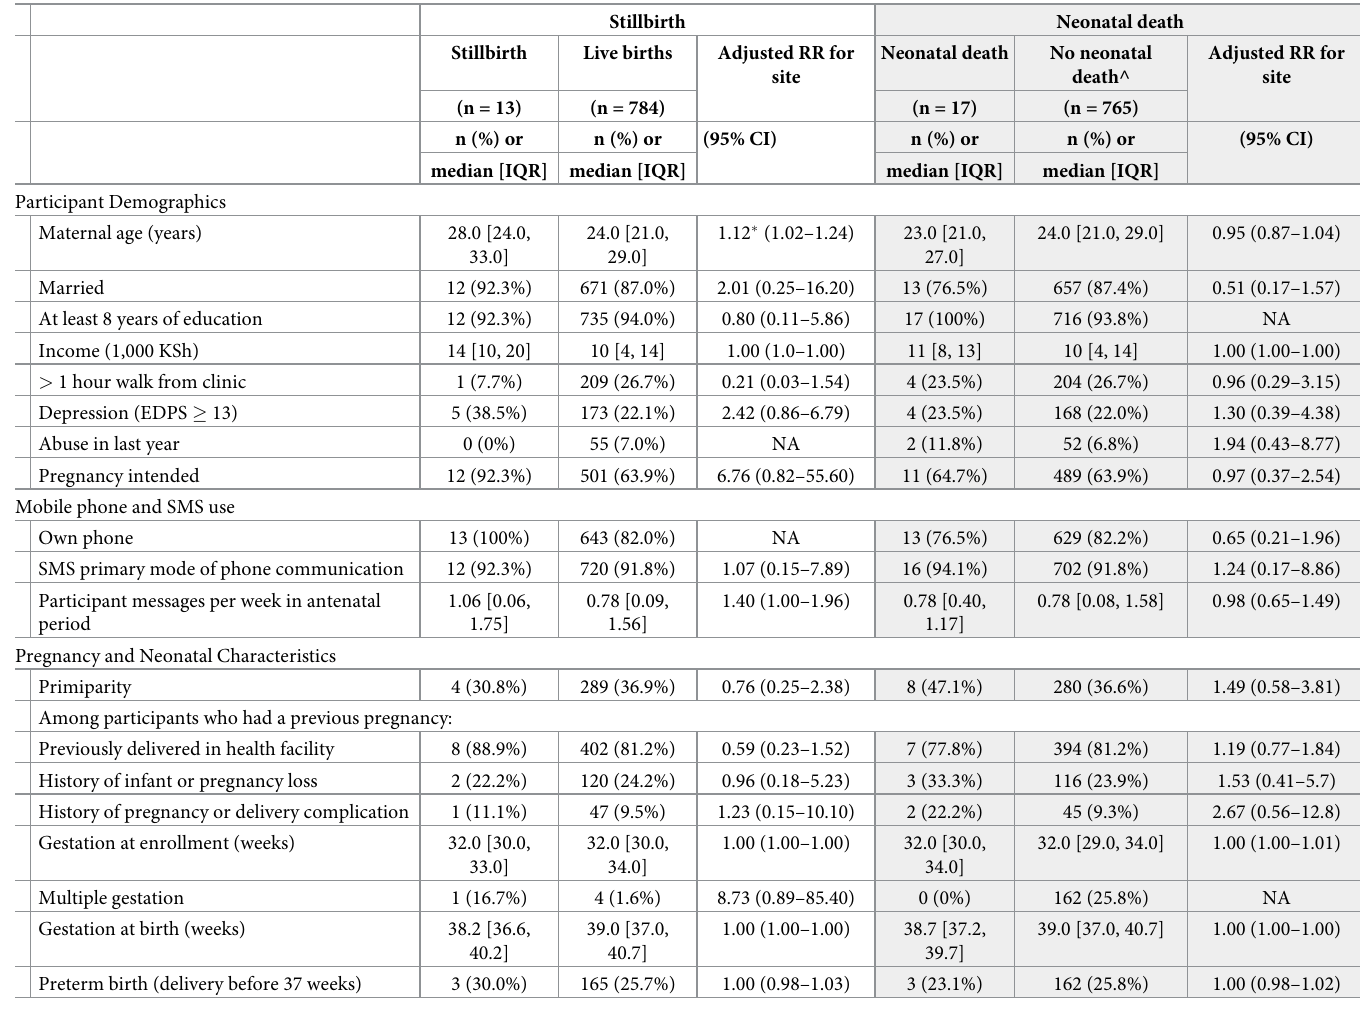
Table 3. Risk factors for neonatal death and stillbirth adjusted for site.